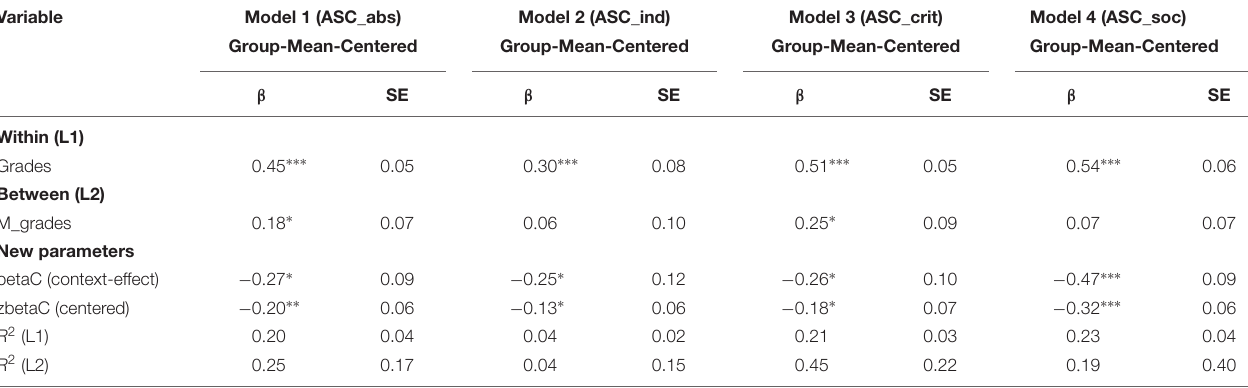
TABLE 3 | Results of the Multilevel Structural Equation Models with grades as independent variable and school self-concept components as dependent